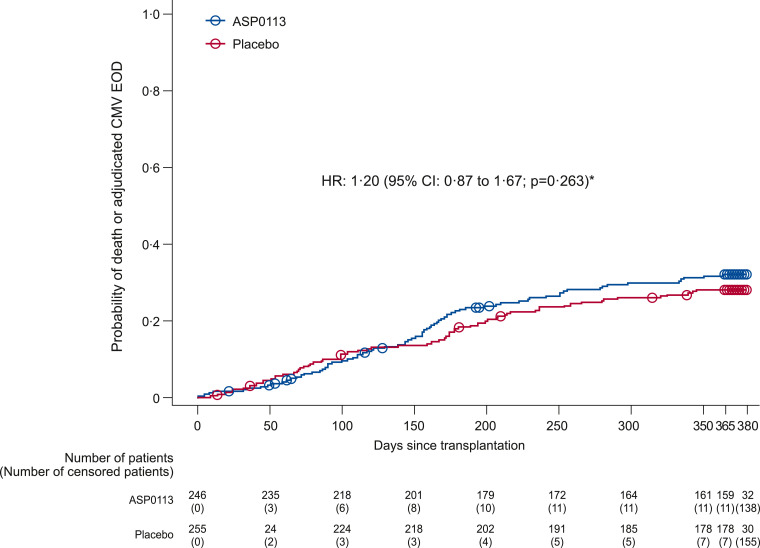
Time to composite of all-cause mortality and adjudicated CMV EOD (full analysis set) *Parameter estimate from a Cox proportional hazards model with treatment and randomisation strata. p-value based on Cox proportional hazards model parameter estimate for the treatment effect. Circles indicate censored observations. CMV=cytomegalovirus; EOD=end-organ disease; HR=hazard ratio.